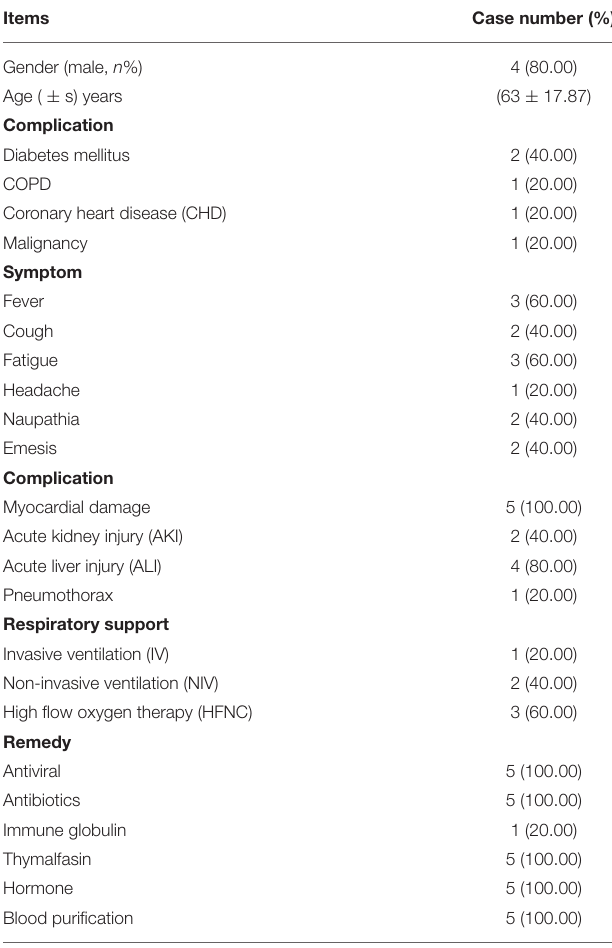
TABLE 1 | Demographic data and clinical